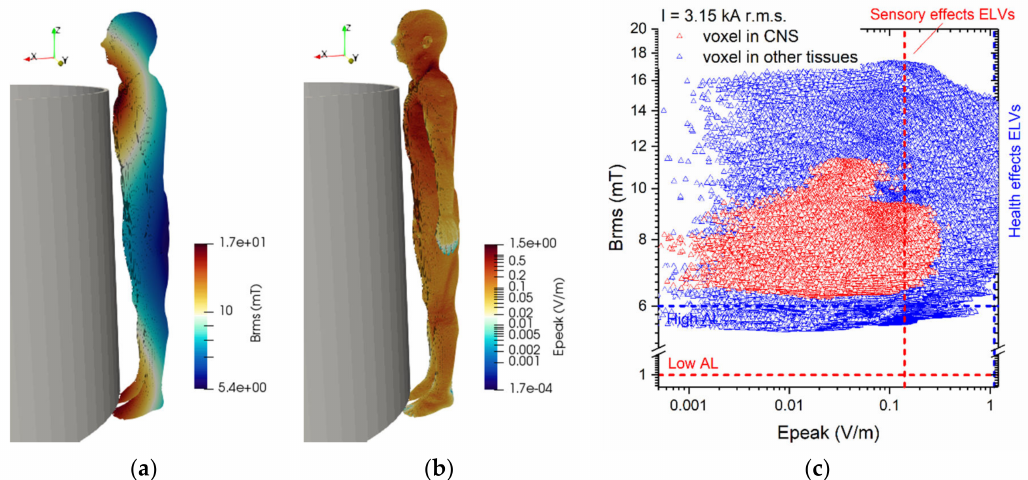
Figure 13. Results for posture B.2. On the left ( a ) the spatial distribution of the B-field amplitude (r.m.s. values, in millitesla) over the body surface. In the middle ( b ) the corresponding spatial distribution of the E-field amplitude (peak values, in volt per metre) over the body surface. On the right ( c ) the distribution of the voxel